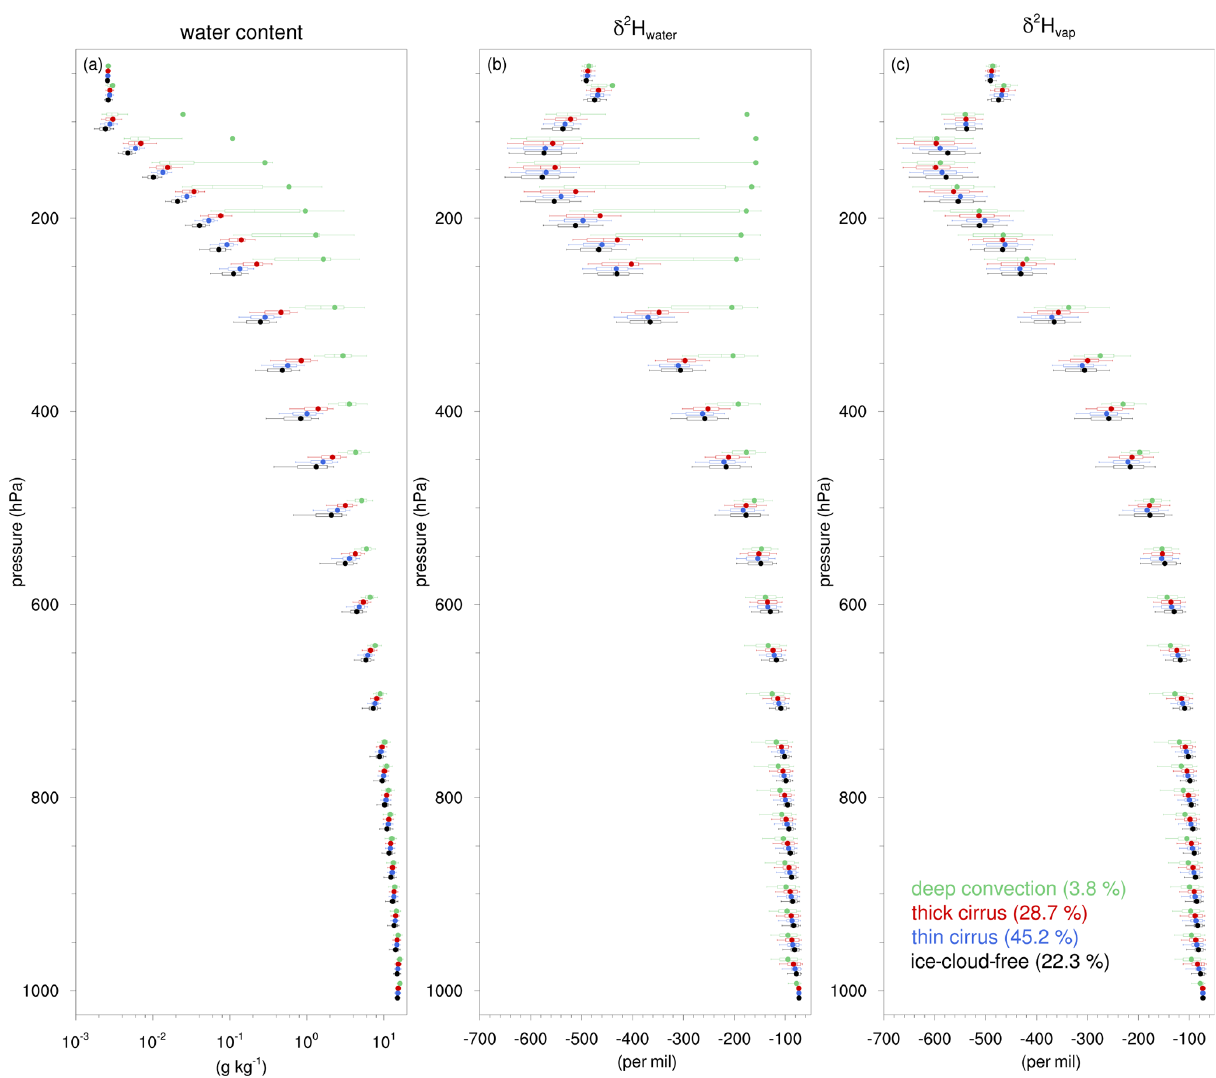
Figure 14. As in Fig. 13 but for the (a) total water content (gkg − 1 ), (b) δ 2 H in total water (‰), and (c) δ 2 H in vapour (‰) for the 50–1000hPa pressure range. In addition, the information on the ice-cloud-free regime is included in